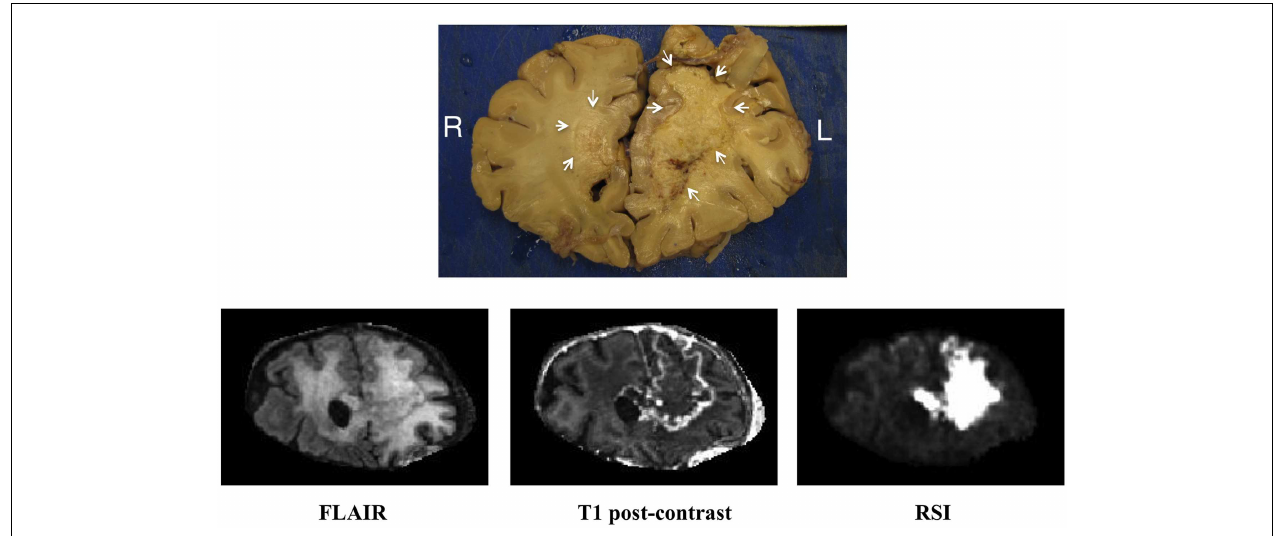
FIGURE 3 | Correlation of the gross pathology with imaging . Coronal gross pathologic specimen as well as matched coronal FLAIR (fluid attenuated inversion recovery), coronalT1 post-contrast, and coronal RSI sequences from the patient’s last available MRI for